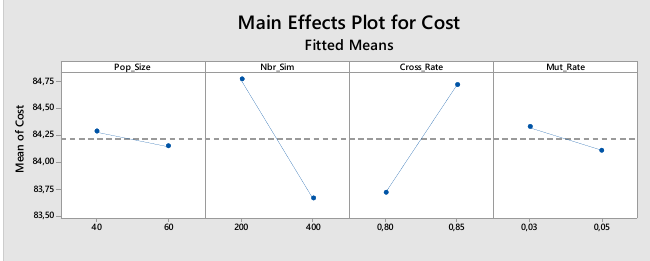
Fig. 6. Main effect plot for Cost